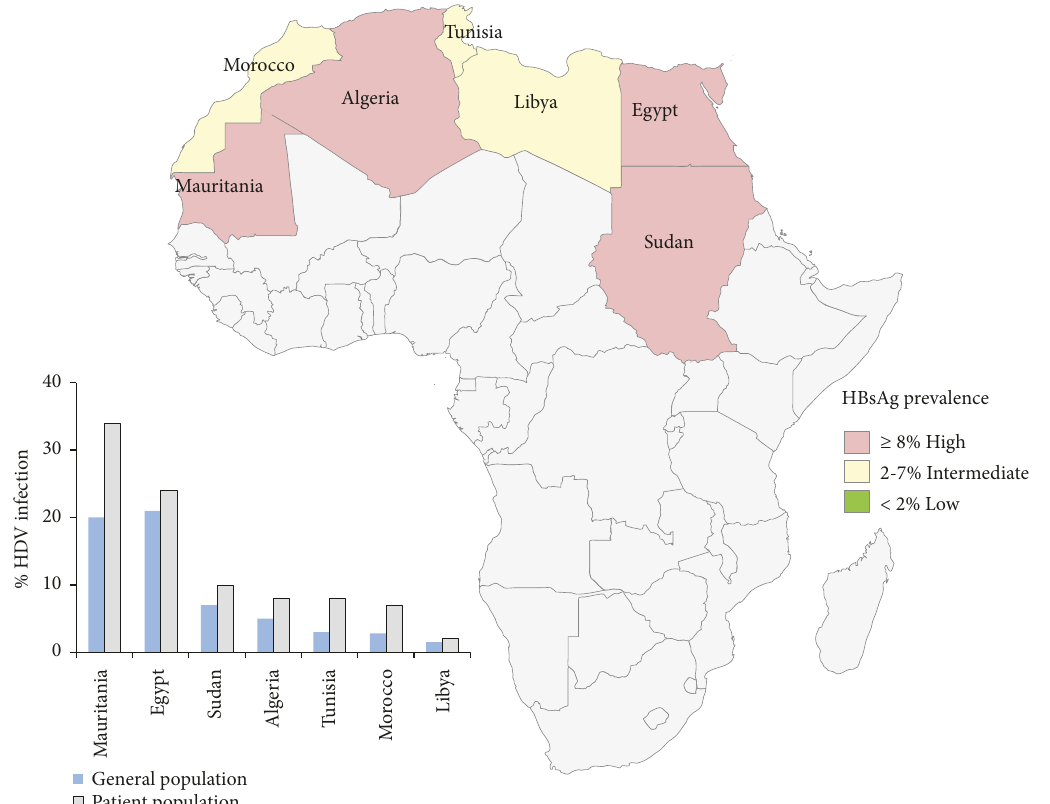
Figure 2: Seroepidemiology of hepatitis D virus in North African populations in studies published during